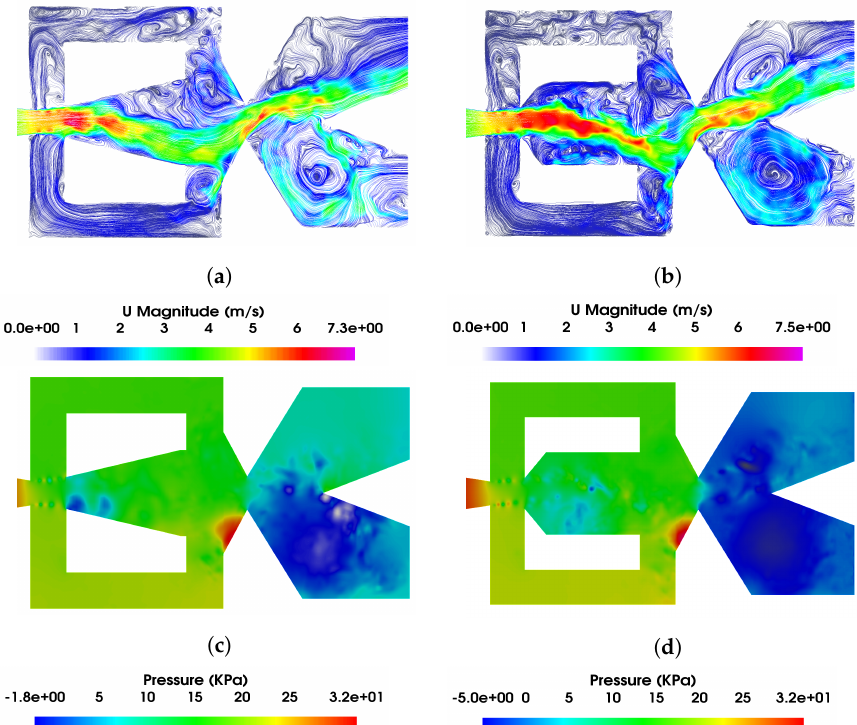
Figure 14. Fluidic oscillator internal velocity field ( a , b ) and pressure magnitude ( c , d ). Maximum inlet angle ( a , c ), minimum inlet angle ( b , d ). Reynolds number